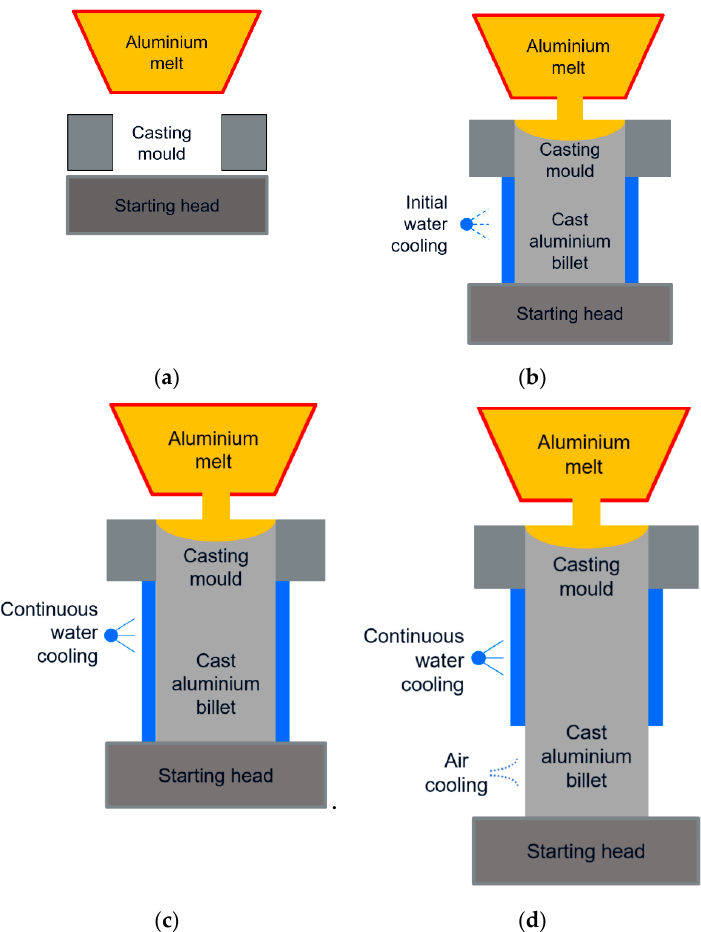
Figure 1. Schematic vertical aluminium casting process with its cooling strategy for; ( a ) start of casting process; ( b ) initial water cooling; ( c ) steady state continuous water cooling and; ( d ) combination of water and secondary air cooling.